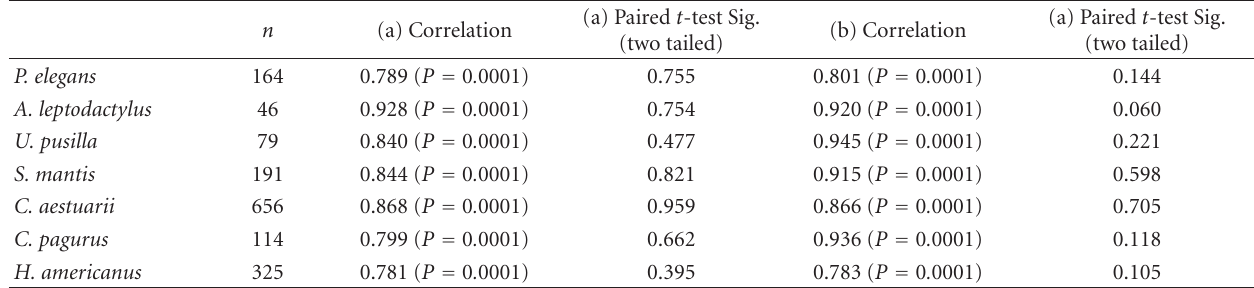
Table 2: Two-tailed paired t -test between total protein measured and calculated from hemolymph density using the specific (a) or the cumulative regression line